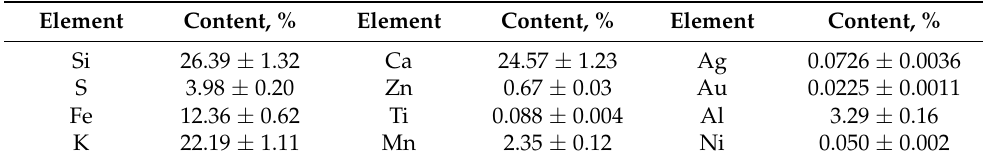
Table 1. Results of the study of the chemical composition of BDO.